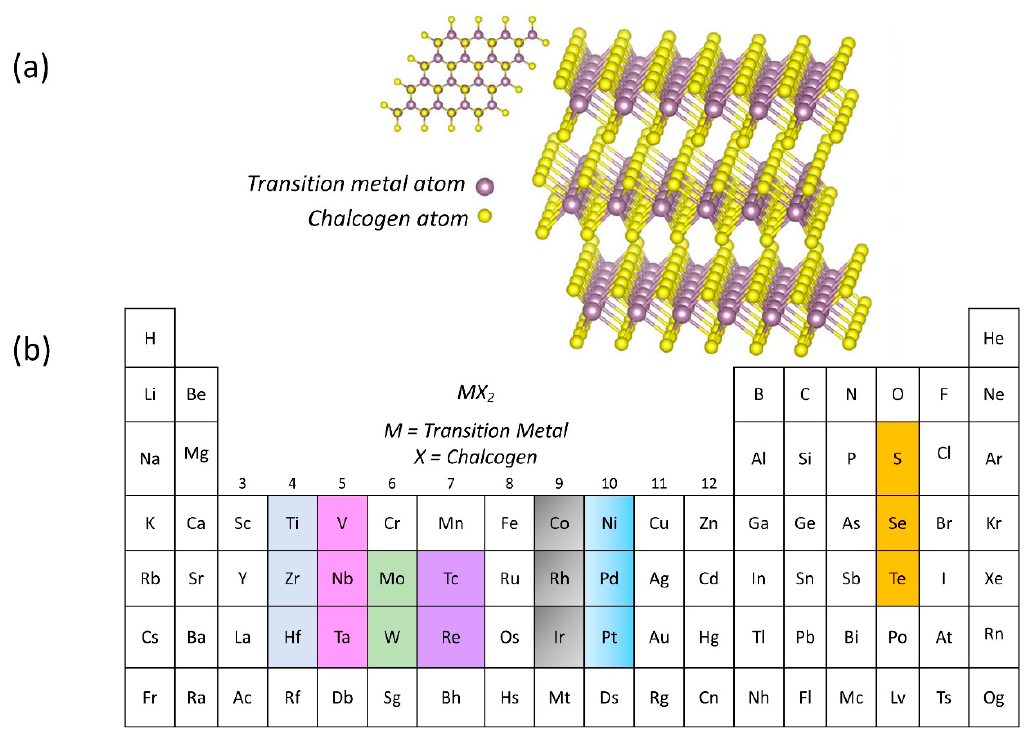
Figure 4. ( a ) General structure of TMDC, where the metal atom (purple) is sandwiched between two chalcogenides atoms (yellow). Reprinted with permission from [100]. Copyright 2021